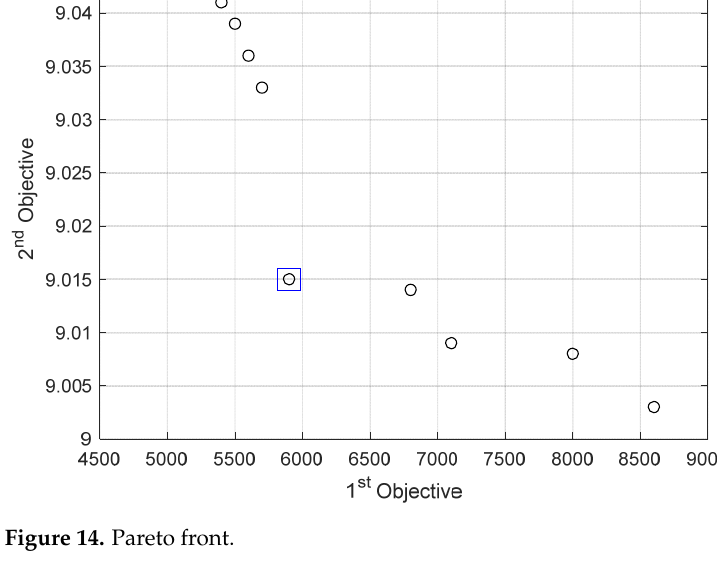
Figure 14. Pareto front.